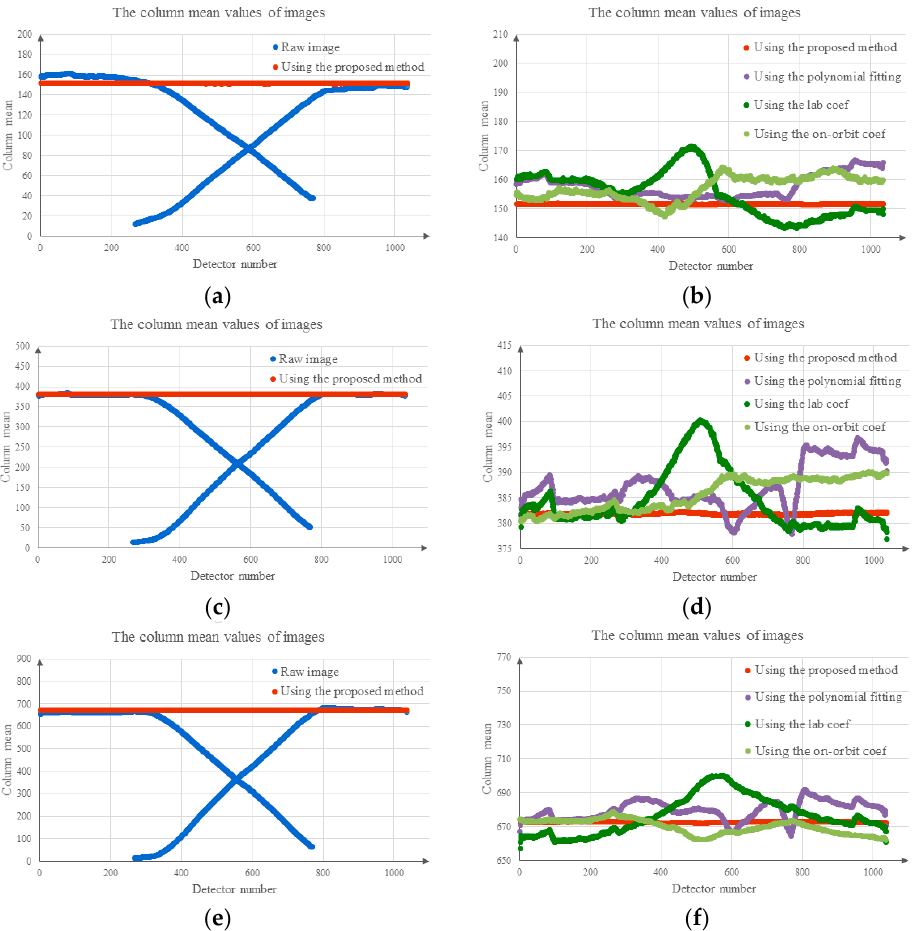
Figure 14. Column mean values for the raw data and corrected images: ( a ) low-brightness region, column mean values for the raw data and results obtained using the proposed method; ( b ) low-brightness region, column mean values for the corrected images; ( c ) middle brightness region, column mean values for the raw data and results obtained using the proposed method; ( d ) middle brightness region, column mean values for the corrected images; ( e ) high-brightness region, column mean values for the raw data and results obtained using the proposed method; ( f ) high-brightness region, column mean values for the corrected images.